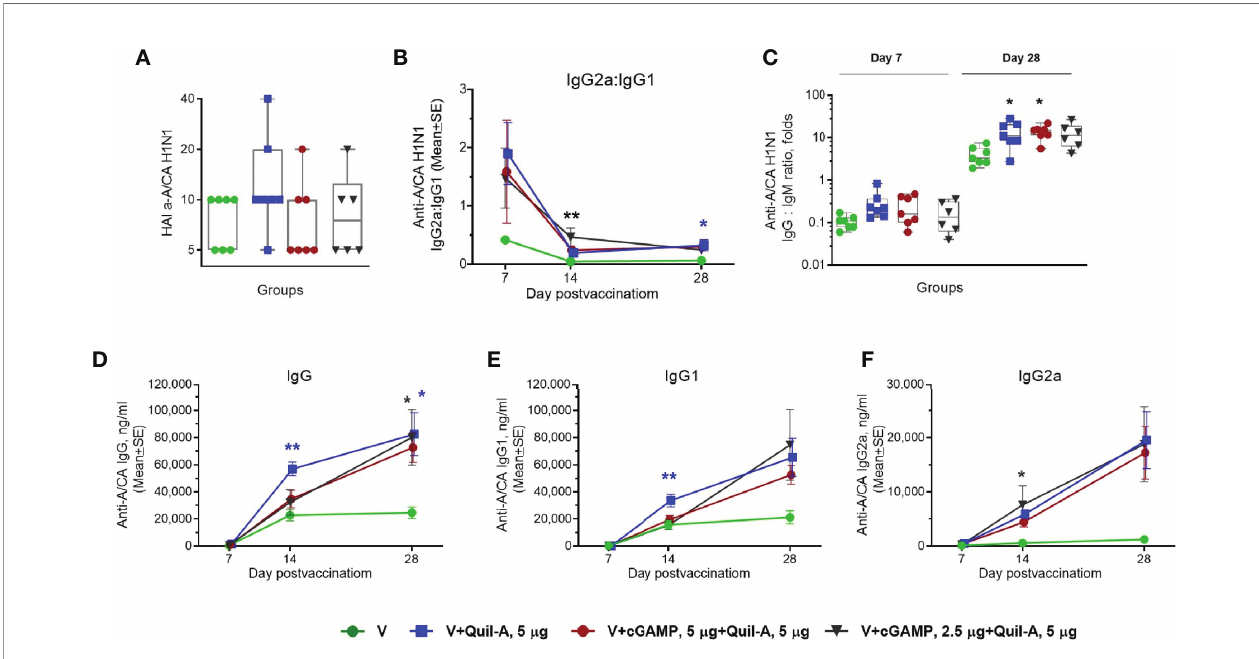
FIGURE 3 | Effect of MNP immunization on the vaccine-speci fi c humoral response in aged mice. Aged 21-month-old animals received a single dose (0.9 ± 0.2 µg HA) of adjuvanted or non – adjuvanted A/California 07/09 H1N1 vaccine. (n=7 in all groups except in the 5 µg Quil-A / 2.5 µg cGAMP group where 1 mouse expired n = 6). (A) Individual HAI titers at day 28 postvaccination. (B) Ratio of vaccine-speci fi c IgG2a to IgG1. (C) Individual ratios of IgG to IgM on days 7 and 28 postvaccination; (D) Vaccine-speci fi c IgG, (E) Vaccine-speci fi c IgG1, (F) Vaccine-speci fi c IgG2a. Stars indicate signi fi cance levels of the differences between adjuvanted and non-adjuvanted group at the same time postvaccination calculated by one-way ANOVA with Tukey ’ s posttest (*p < 0.05, **p <